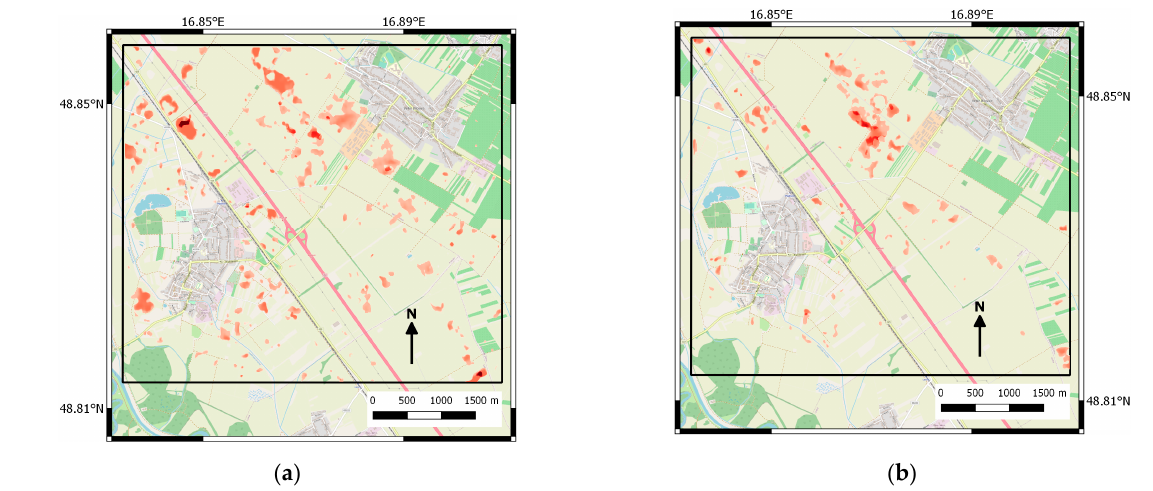
Figure 18. False-positive flood detection in south Moravia from Sentinel-1 images in track A73 from ( a ) 11 April and ( b ) 29 April 2019. Flooded areas are shown in red using the same colour scale as in previous figures. Source of background map: Open Street Map (OSM).